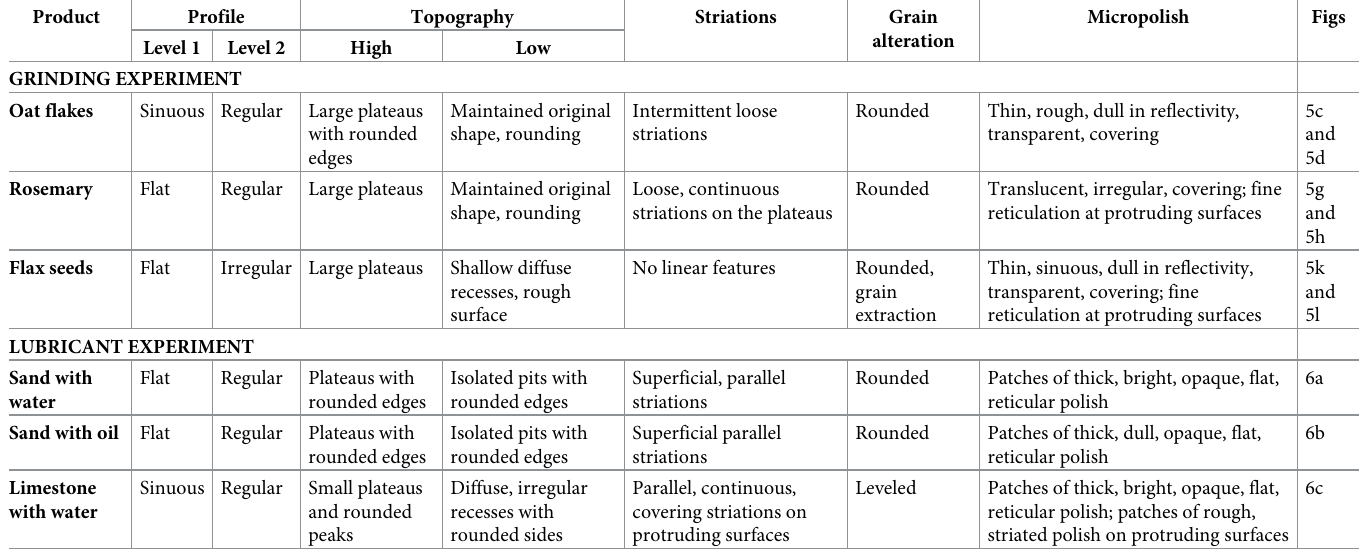
Table 4. Description of traces produced in the second grinding and lubricant